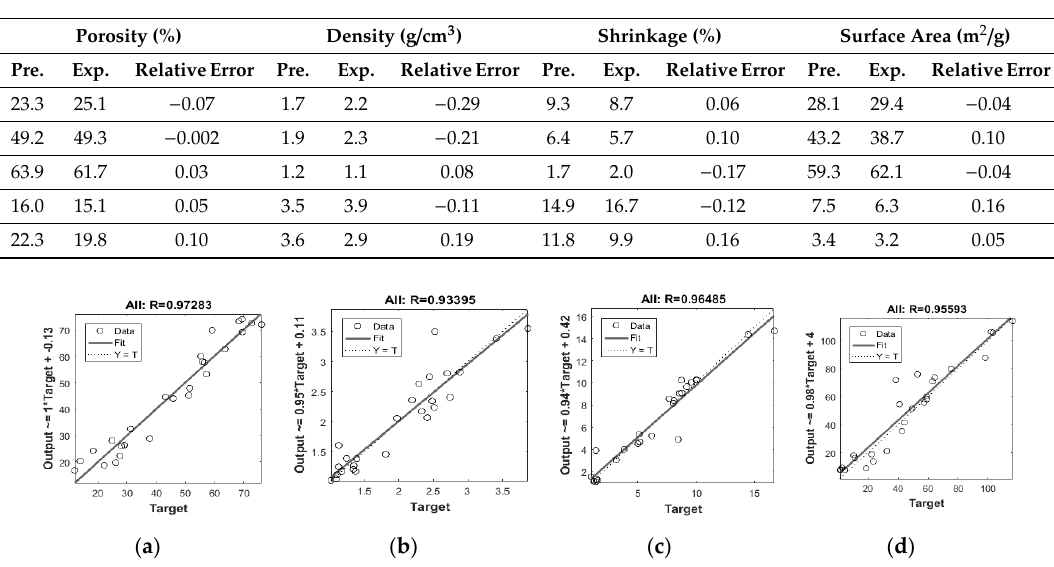
Figure 2. Neural network training regression for ( a ) porosity, ( b ) density, ( c ) shrinkage, and ( d ) surface area.